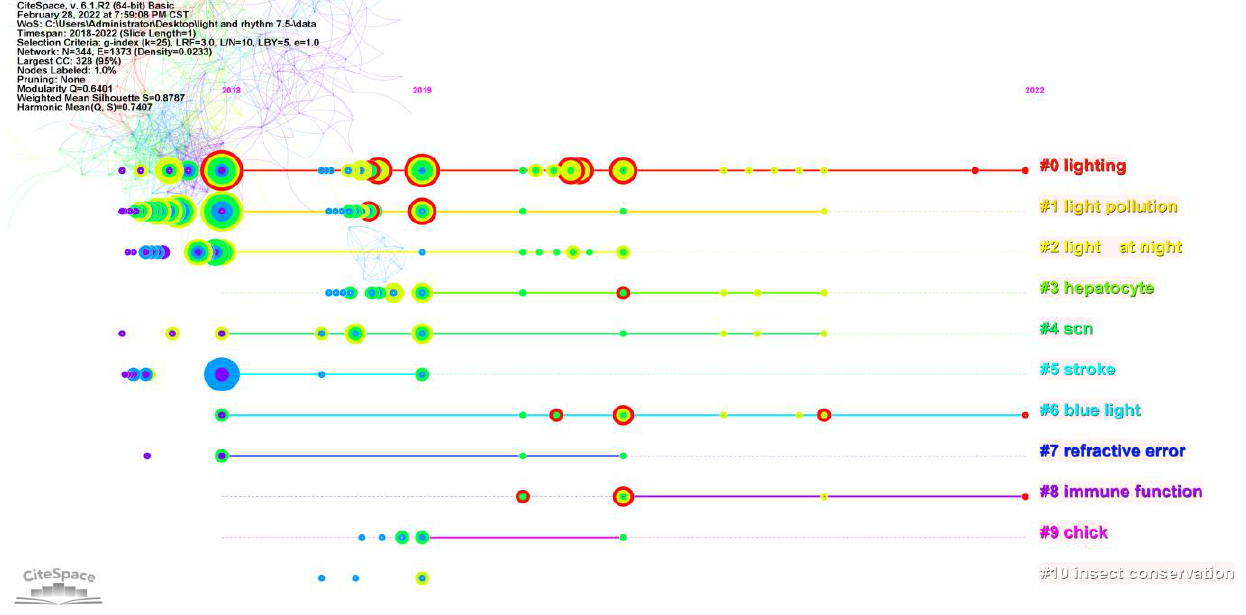
Figure 5. Timeline view of research frontiers (The size of the node is proportional to the number of